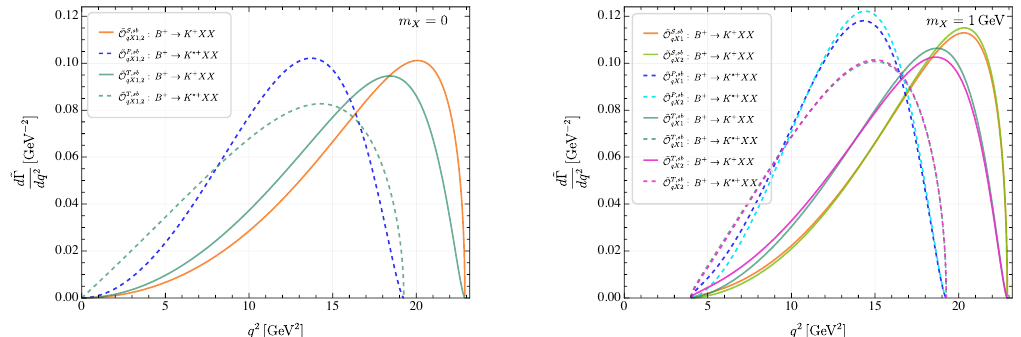
Figure 8 . Normalized differential decay width for B → K ( ∗ )+ XX from different operators in the second scenario for vector DM. Left panel : m = 0 ; Right panel : m = 1 GeV